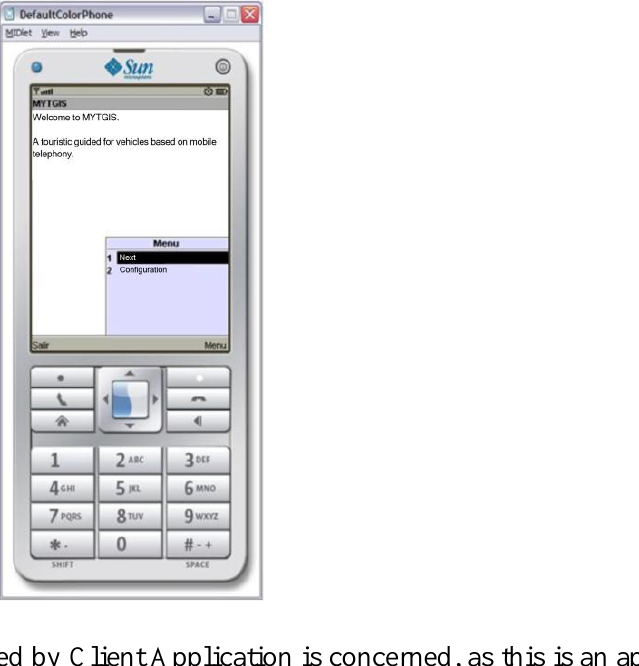
Figure 2. Client application screen executing on a mobile